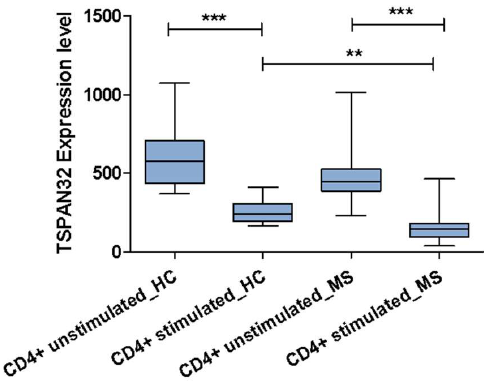
Figure 6. Modulation of TSPAN32 in multiple sclerosis. Expression of TSPAN32 resting and activated CD4 + T cells from 14 relapsing-remitting MS patients and 14 healthy donors, as obtained from the GSE78244 dataset. Data are shown as normalized mean ± SD and statistical analysis performed using one-way ANOVA followed by Bonferroni multiple test correction. **, p < 0.01, ***, p < 0.001.